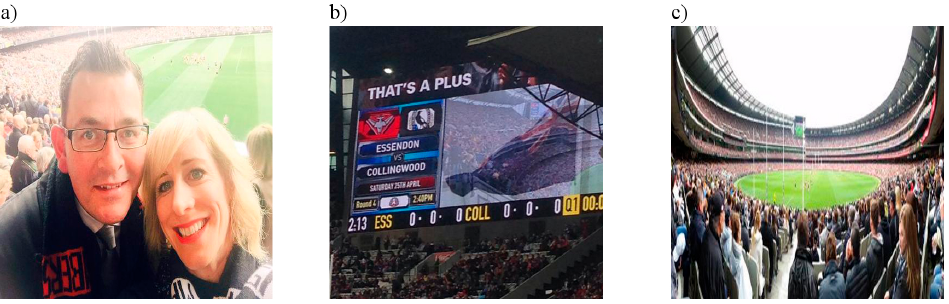
Figure 13. Example of false negative images for the training dataset ADon ( a ) a selfie [70] ( b ) close-up of the scoreboard [71] and ( c ) a panorama [72]. These versions of the images are those which have undergone resizing.